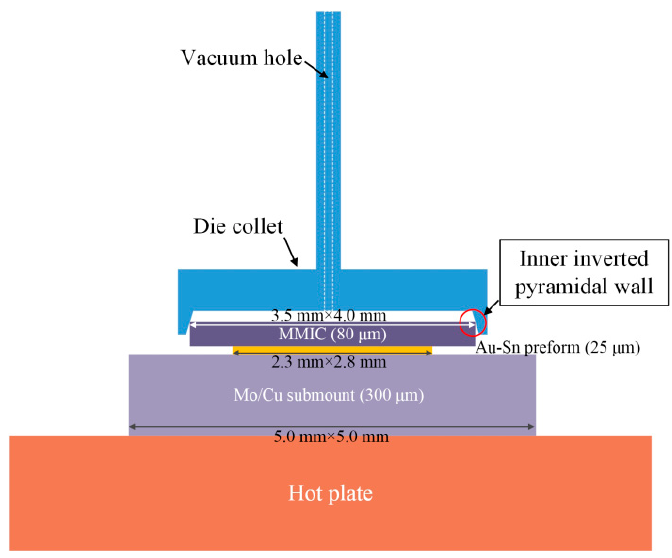
Figure 1. Schematic diagram of Au-Sn eutectic bonding.